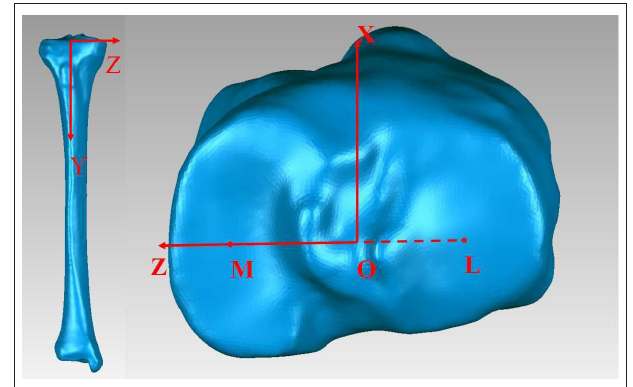
FIGURE 1 | M, the center of the medial tibial plateau; L, the center of the lateral tibial plateau; O, the origin of the coordinate system.